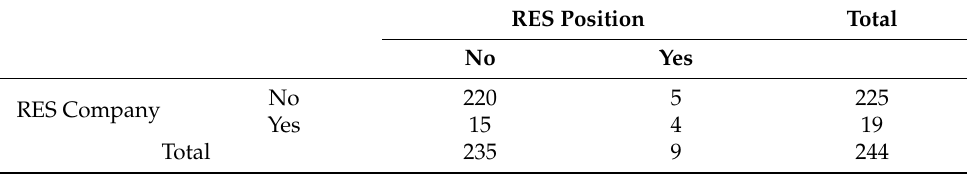
Table 19. Descriptive statistics of hard and soft skills within administrative positions